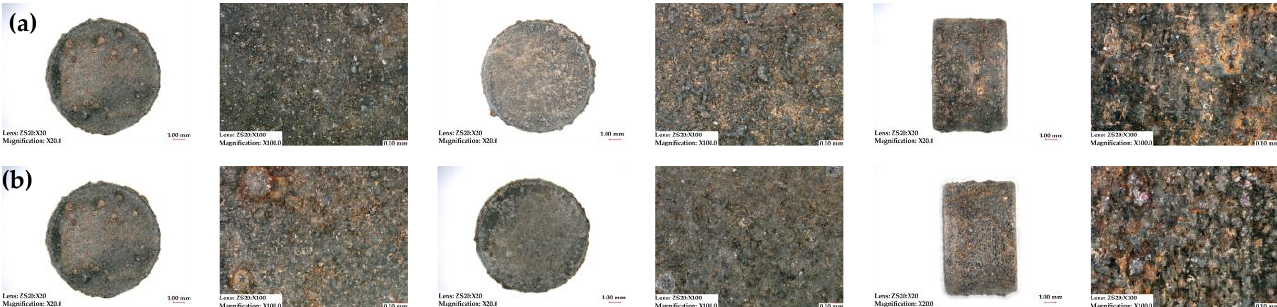
Figure 12. Surface corrosion of samples S90/10 ( a ) and B90/10 ( b ): top, bottom, and side after immer- sion in corrosive water at 95 °C for 1000 h.